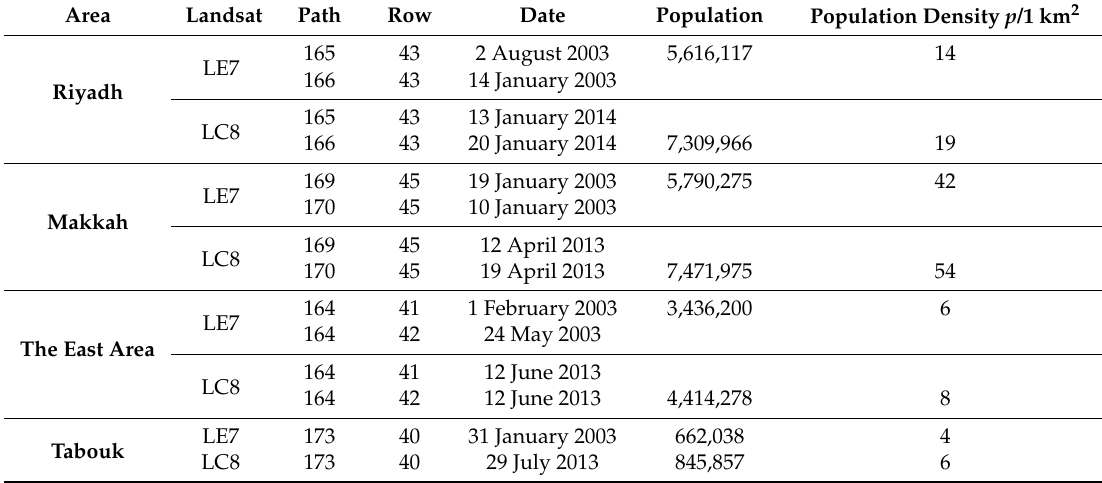
Table 1. Study areas, population, and selected Landsat images used for this